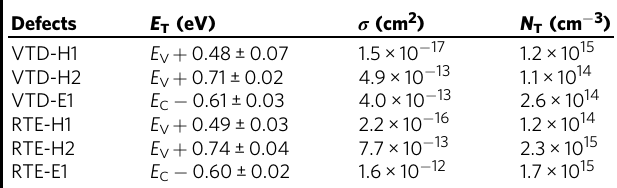
Table 1 Defect parameters of VTD- and RTE-fabricated